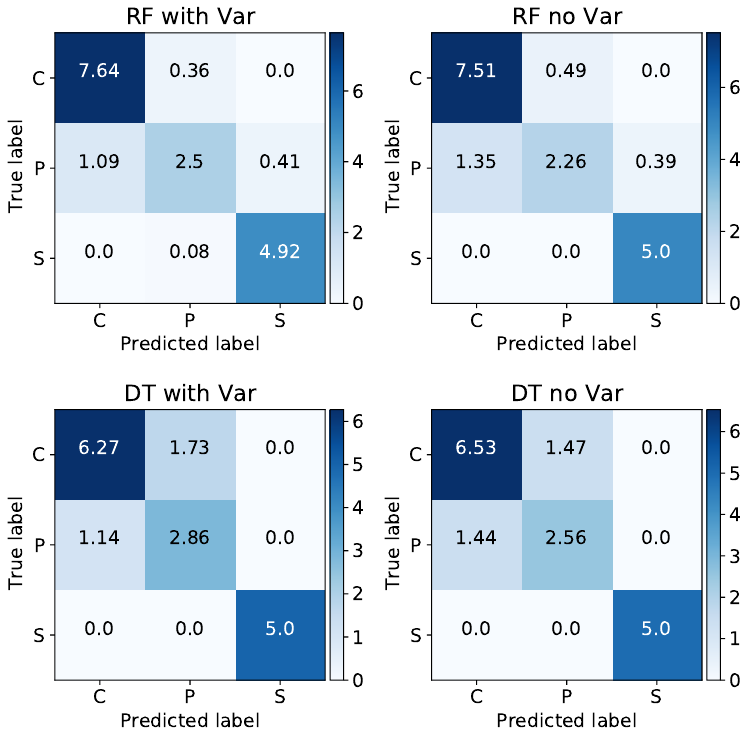
Figure 6. Confusion matrices for Random Forest (RF) with and without variances (on the top row) and the corresponding application of DT (on the bottom